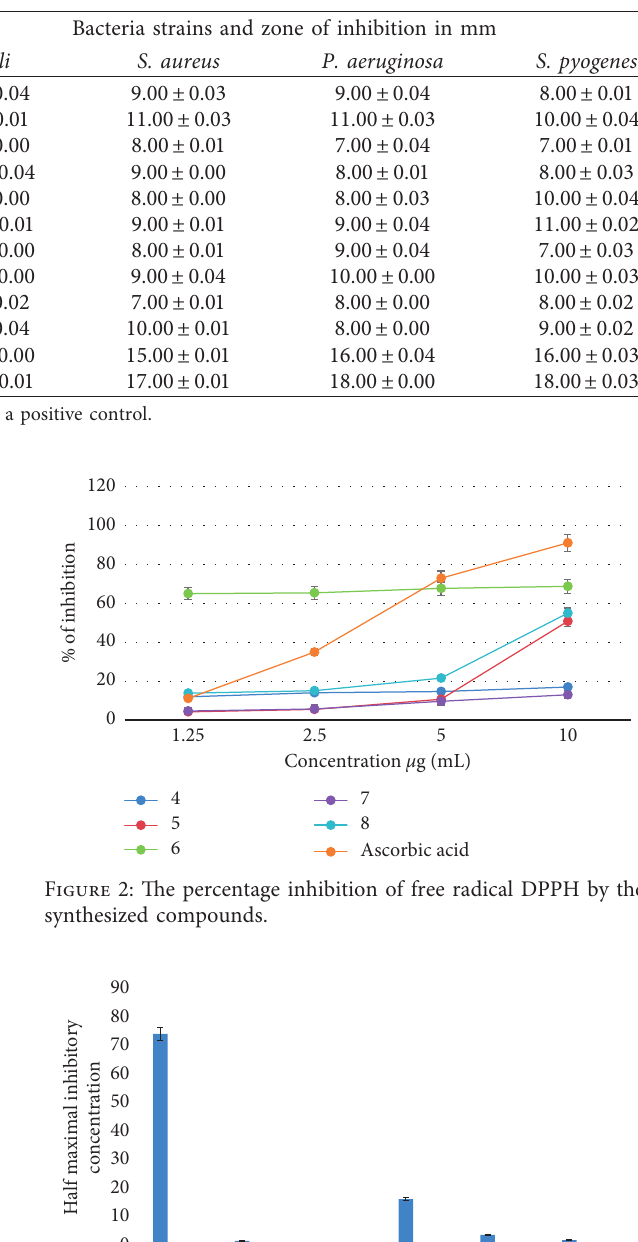
Table 1: The inhibition zone of synthetic compounds in mm (mean ± SD).